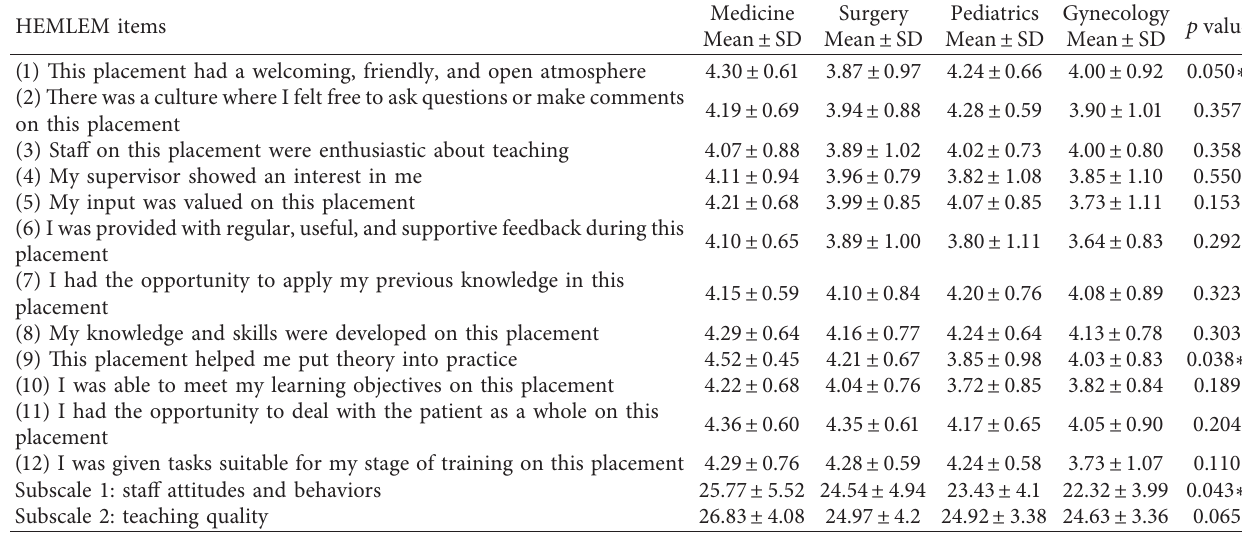
Table 3: Specialty-wise scores on HEMLEM items and